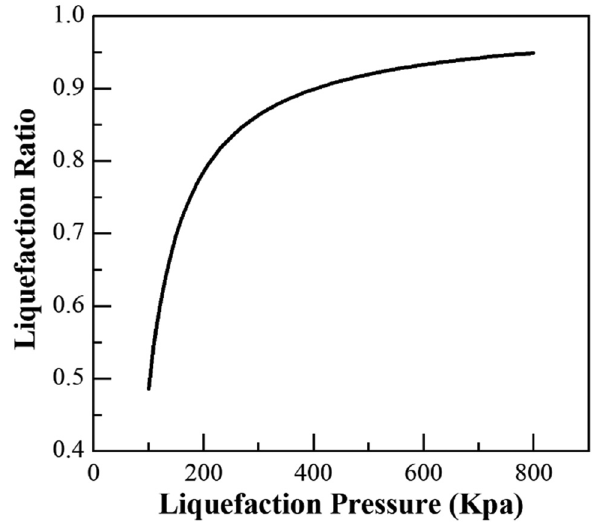
Figure 6: Relationship between the pressure and the liquefaction rate of CS 2